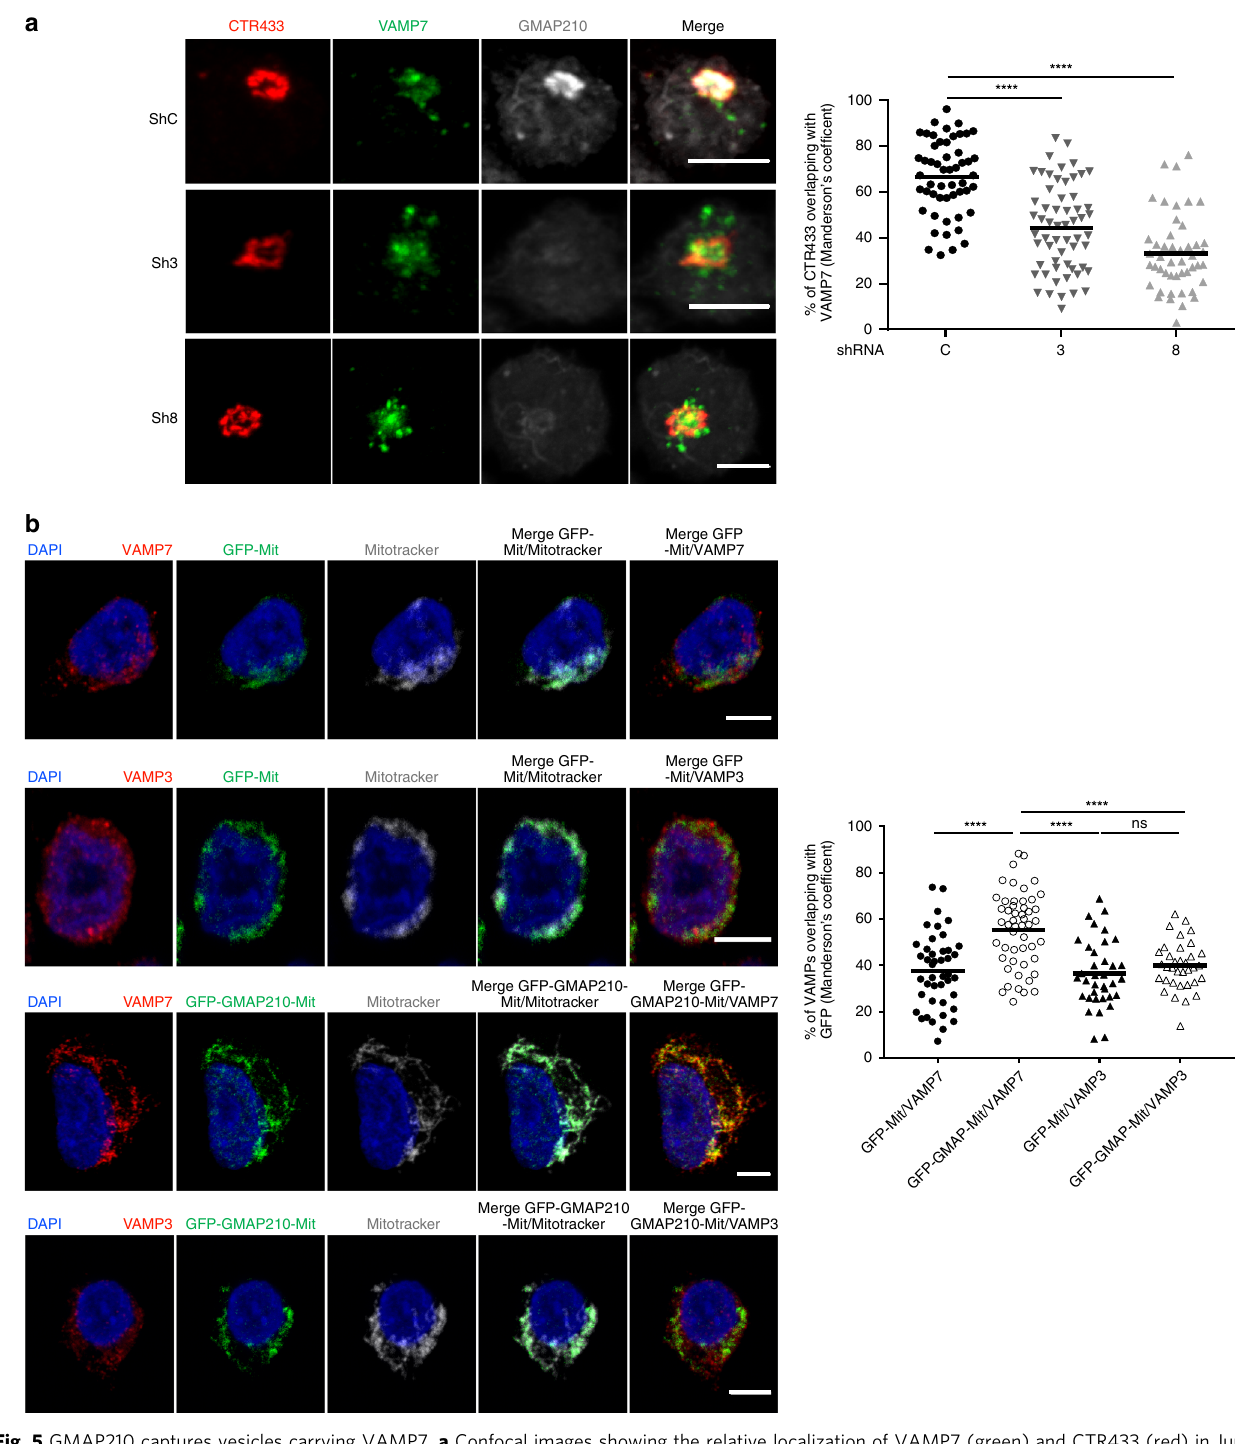
Fig. 5 GMAP210 captures vesicles carrying VAMP7. a Confocal images showing the relative localization of VAMP7 (green) and CTR433 (red) in Jurkat cells expressing control (ShC) or GMAP210 speci fi c shRNA (Sh3, Sh8) (GMAP210, nucleus in gray). Dot plot on the right side of the panel show the quanti fi cation of the percentage of CTR433 (Golgi marker) overlapping with VAMP7 (Manderson coef fi cient). Scale bar 5 μ m. Each dot = one cell; horizontal lines = median. **** P < 0.0001 (one-way ANOVA). b Confocal images showing the localization of VAMP7 or VAMP3 (red) in Jurkat cells expressing a GFP-GMAP210-ActA chimera (GFP-GMAP210-Mit) or a GFP-ActA chimera (GFP-Mit), treated for 4 h with nocodazol (5 μ g/mL) (nucleus in blue and mitochondria in Gray). Dot plot on the right side of the panel shows the quanti fi cation of the percentage of VAMPs (VAMP7 or VAMP3) overlapping with the GFP staining (GFP-mit or GFP-GMAP210-mit, Manderson coef fi cient). Scale bar 5 μ m. Each dot = one cell; horizontal lines = median. **** P < 0.0001, ns: non-signi fi cant (one-way ANOVA). Data and Images represent two independent experiments in a and